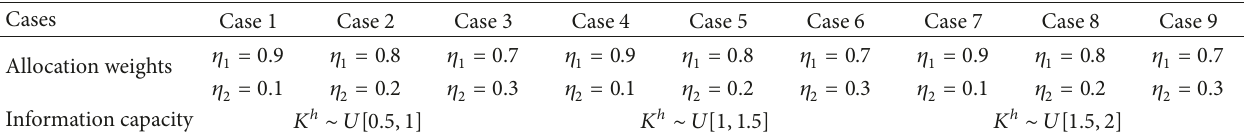
Table 2: Different parameter combinations of information capacity and allocation